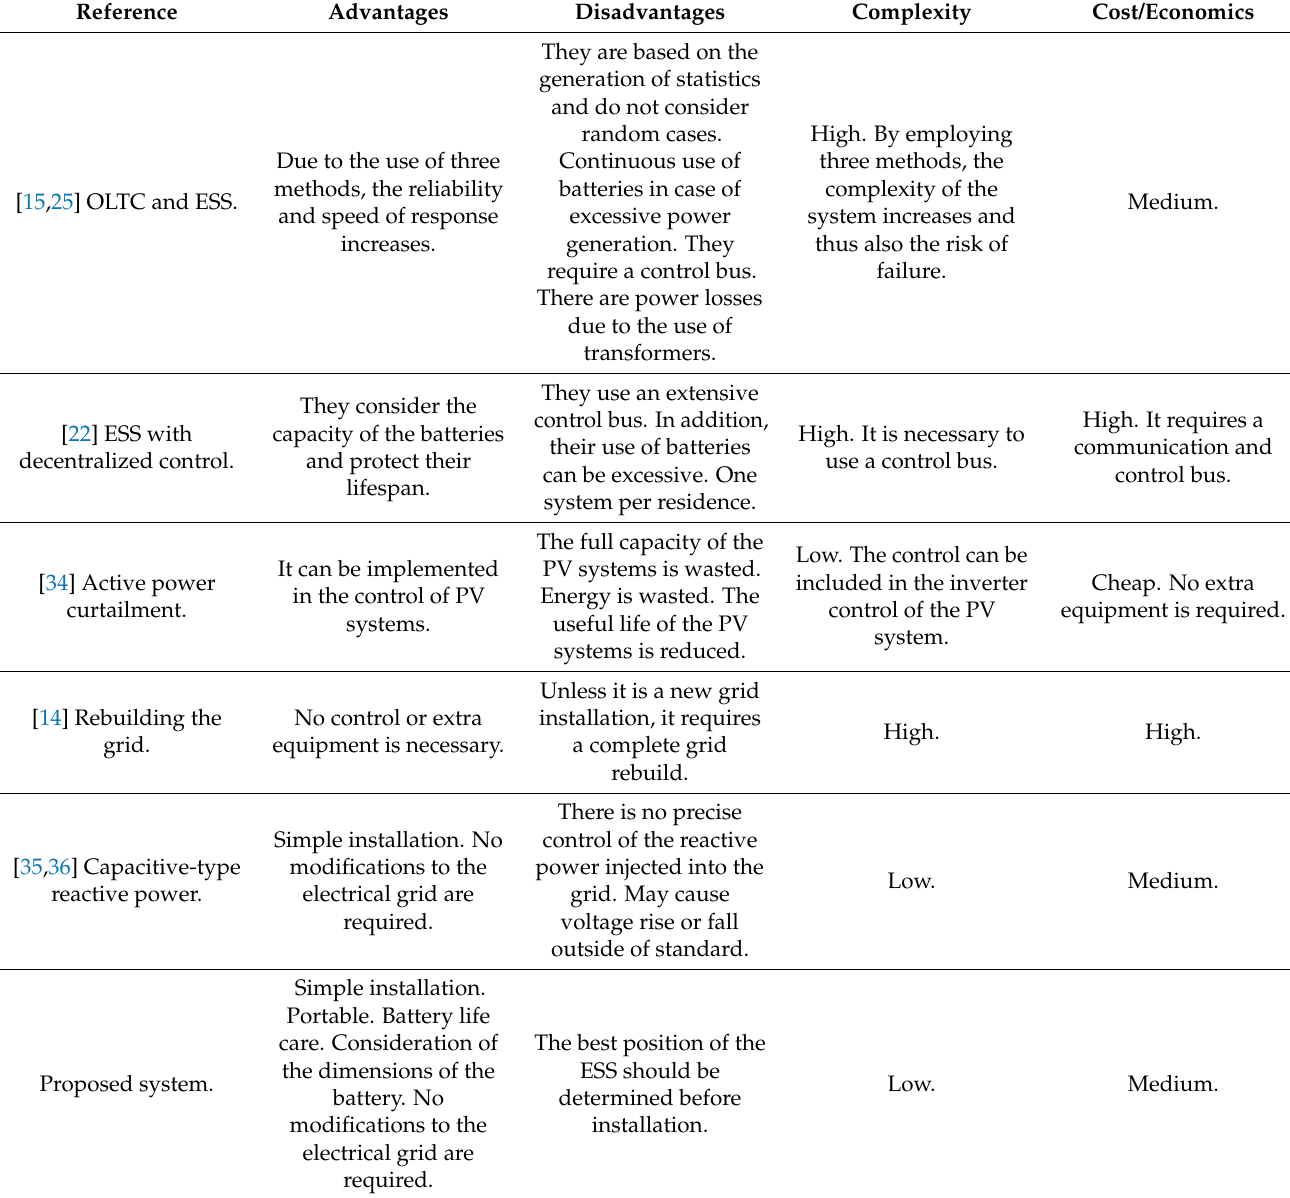
Table 3. Techniques to alleviate the damaging effects of a high penetration of PV